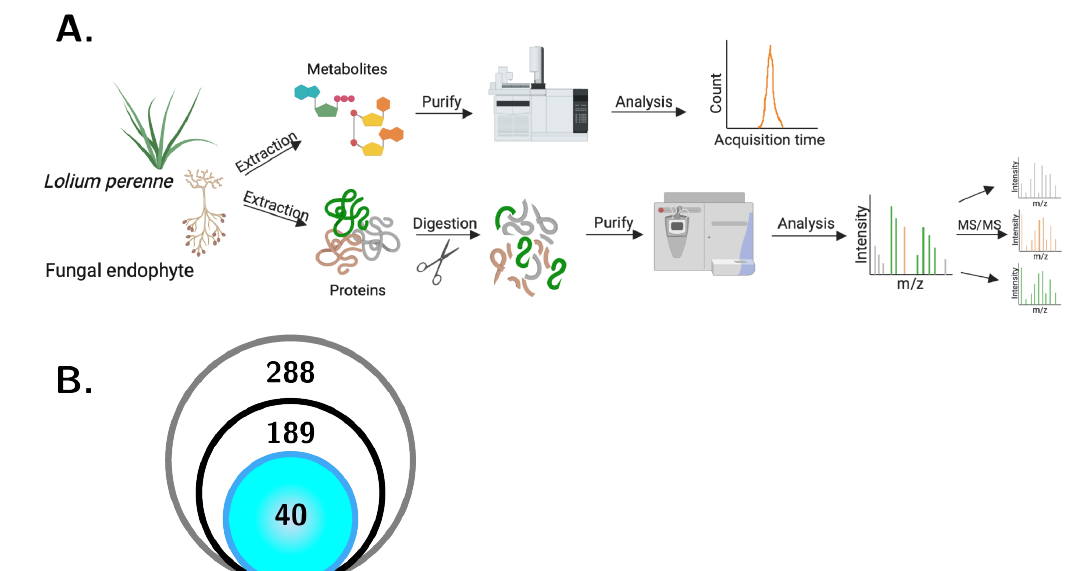
Figure 3. Overview of OMICs analysis. ( A ) Total plant biomass of L. perenne samples colonized with an endophyte (AR1, AR37, E+, or NEA2) were collected and subjected to a metabolite extraction protocol followed by mass spectrometry (LC-MS). In addition, pseudostem tissue of L. perenne samples colonized with an endophyte (AR1, AR37, E+, or NEA2) was collected and subjected to a protein extraction protocol followed by enzymatic digestion and tandem mass spectrometry (LC-MS/MS; figure generated using https://biorender.com). ( B ) In total, 288 samples were collected and processed for metabolomic profiling (grey). Of these, 189 samples were of substantial quality to proceed to mass spectrometry for metabolite identification (black), and a subset of 40 samples was selected for proteomic profiling (blue shading; 10 each from one family nested in each strain, of which 5 were from 400 ppm and and 5 were from 800 ppm CO 2 —see Table